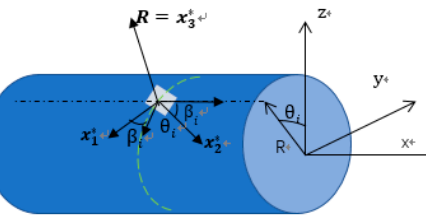
Figure 2. Location and coordinate of strain sensor placed on the external beam surface.